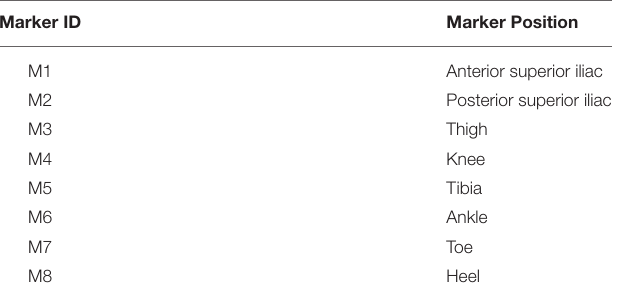
TABLE 3 | Marker placement for VICON system.